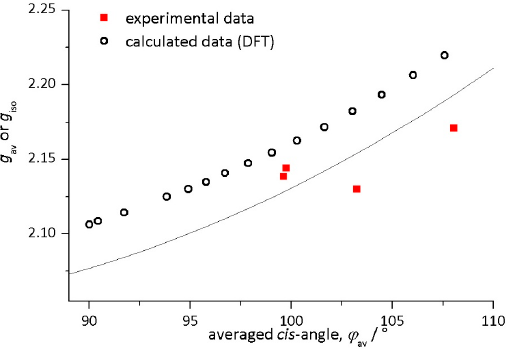
Figure 4. Correlation of EPR parameter ( g av / g iso ) with the coordination geometry (averaged cis -angle) including the four new data sets from Table 6 (squares); the circles represent the calculated data (DFT).